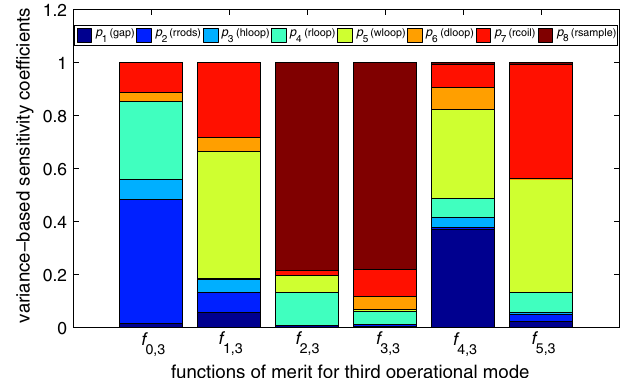
FIG. 7. Algorithm for the PC-SCM employing CST STUDIO SUITE ® [44] as “ black-box ” simulation engine. In the flow p Þ . indicated above Dakota [68] has been · ; 3 ð